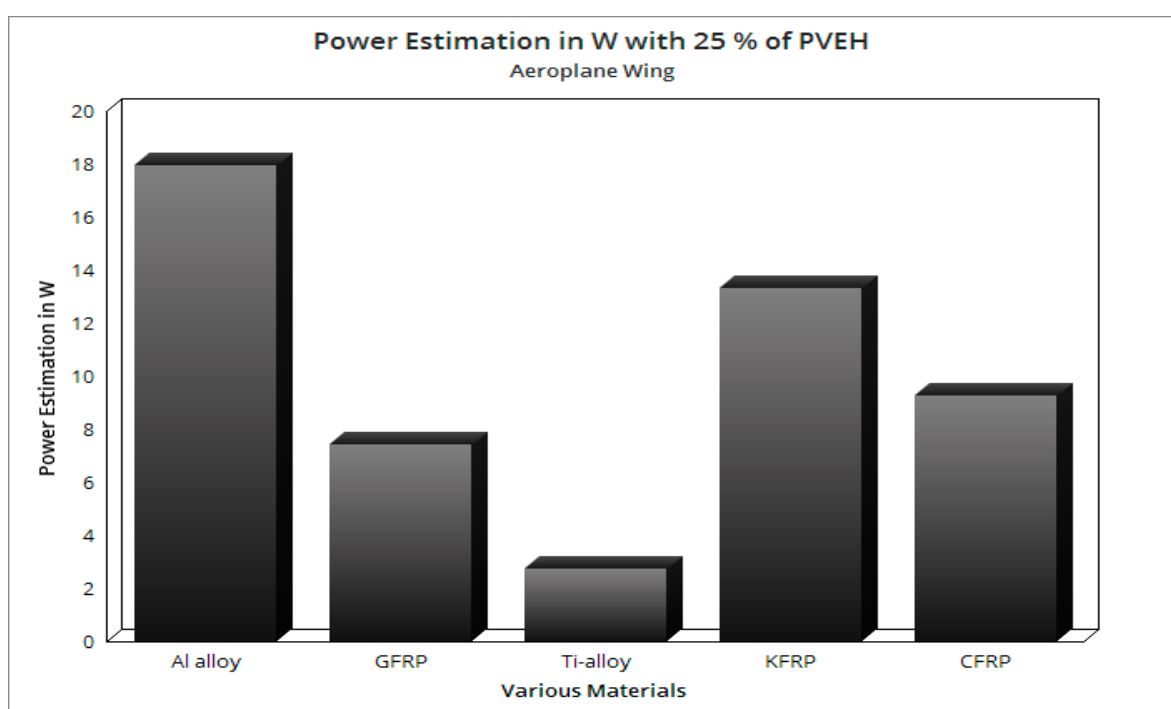
Figure 33. Power (P 0 ) in W with 25% attachment coverage—airplane wing.